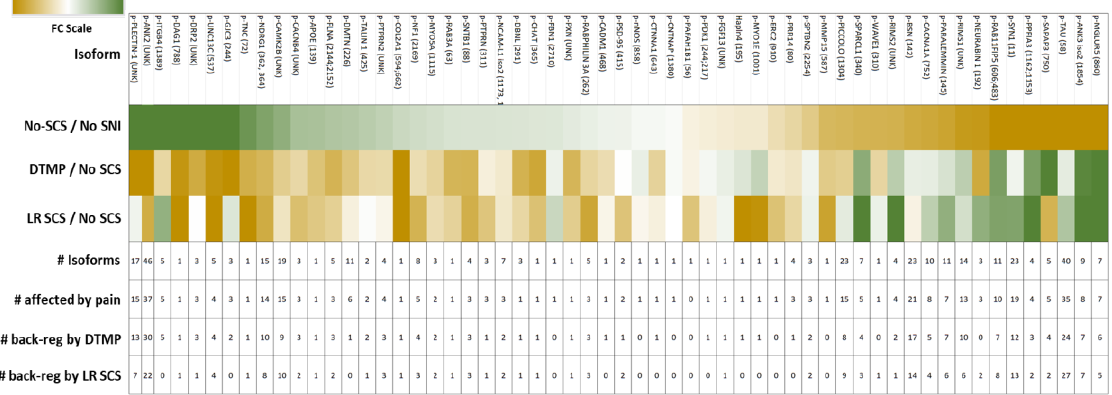
Figure 6. Heat map with expression level fold changes (FC) of selected ECM phosphoproteins isoforms associated with the cell signaling. Isoforms with the largest expression change due to the pain model are shown for each phosphoprotein. Values in the table below the heat map indicate the number of isoforms identified, how many were affected by the pain model and how many of these were back-regulated (back-reg) by DTMP or LR SCS.